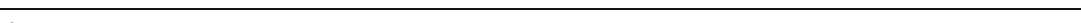
(See figure on previous page.) Fig. 3 Landslide susceptibility maps for Quito: ( a ) Multi-criteria evaluation (MCE) official map. From LOGIT modelling results: ( b ) Six-factor with weights encoding ( c ) Eight-factor with weights encoding ( d ) Ten-factor with weights encoding ( e ) Ten-factor with percentile discretization. Legend: All maps have been classified in 5 categories by the geometrical interval method in GIS (ArcMap 10.3). Other features: Study Area (black